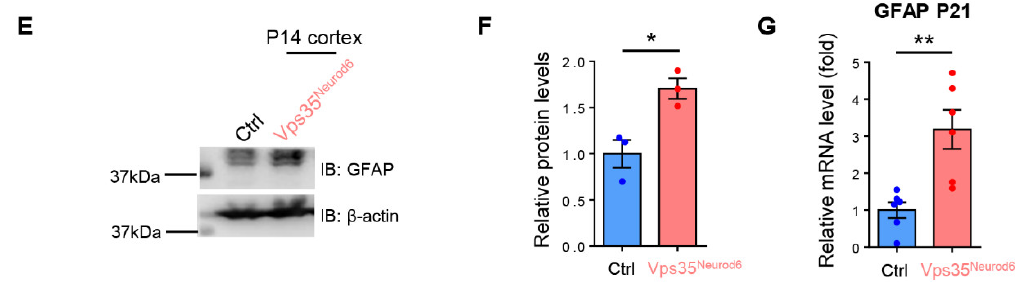
Figure 6. Altered GFAP + astrocyte distribution in Vps35 Neurod6 cortex. ( A ) Representative images of cortical brain sections coimmunostained with PECAM-1, SMA, SLC16A1, and GFAP at P14. ( B ) Quantification analysis of GFAP intensity, PECAM-1 + BV associated with GFAP, SMA + BV associated with GFAP, and SLC16A1 + BV associated with GFAP in control and Vps35 Neurod6 mice (n = 3~4 mice per group; two-tailed unpaired t test). ( C ) Representative images of cortical brain sections coimmunostained with PECAM-1, SMA, SLC16A1, and GFAP at P21. ( D ) Quantification analysis of GFAP intensity, PECAM-1 + BV associated with GFAP, SMA + BV associated with GFAP, and SLC16A1 + BV associated with GFAP in control and Vps35 Neurod6 mice (n = 3~4 mice per group; two-tailed unpaired t test). ( E , F ) Western blot analyses ( E ) and quantification analysis ( F ) of GFAP level in the cortex taken from Vps35 f/f and Vps35 Neurod6 animals. β -actin was employed as a loading control (n = 3 animals per genotype; two-tailed unpaired t test). ( G ) Analysis of GFAP mRNA level in Vps35 f/f and Vps35 Neurod6 animals at P21 (n = 3 animals per genotype; two-tailed unpaired t test). Scale bars as indicated in each panel. Individual data points are shown as dots with group mean ± SEM; * p < 0.05; ** p < 0.01; ns., not significant.